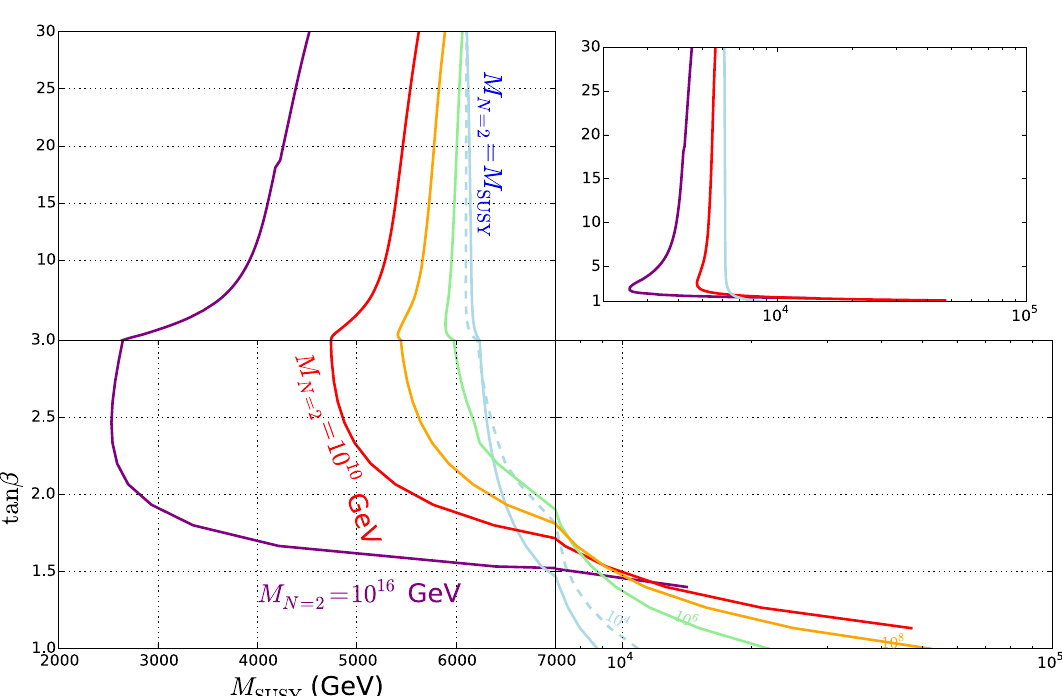
tle change for large tan β we have split the plot into three quadrants to show the values more clearly, but for comparison we give an inset graph showingthethreecurves M N = 2 = { M SUSY , 10 10 GeV , 10 16 GeV } with M SUSY (GeV) on a logarithmic scale on the abscissa and tan β on a lin- ear scale on the